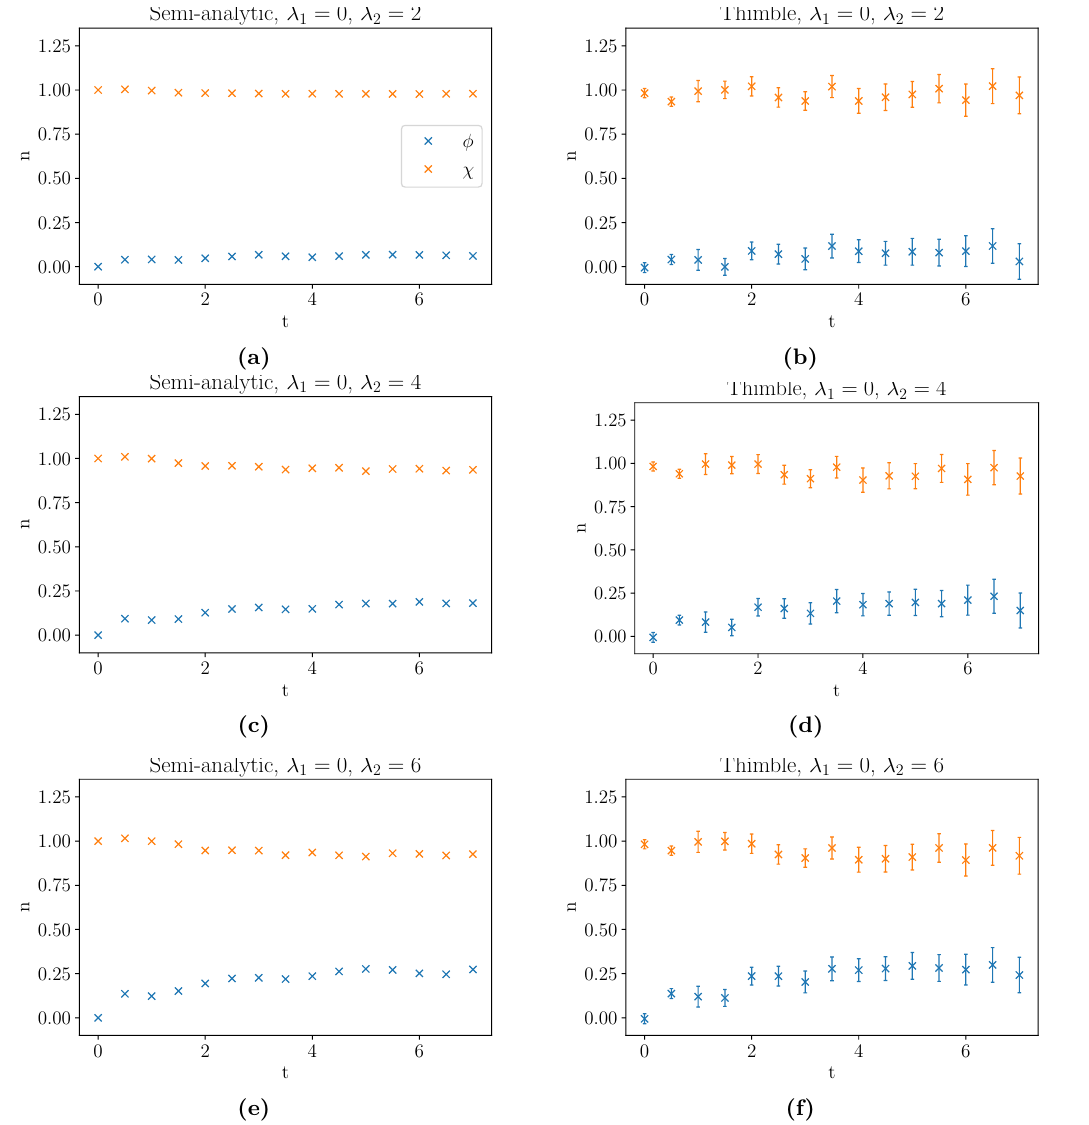
Figure 11. Semi-analytic (left) and Thimble (right) occupation numbers for two fields interacting with different values of the parameter λ 2 , λ 1 = 0